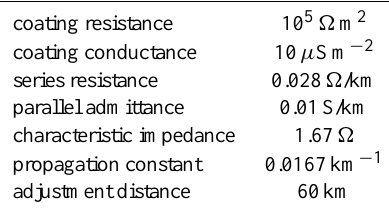
Table 1. Electrical characteristics of the Norman Wells to